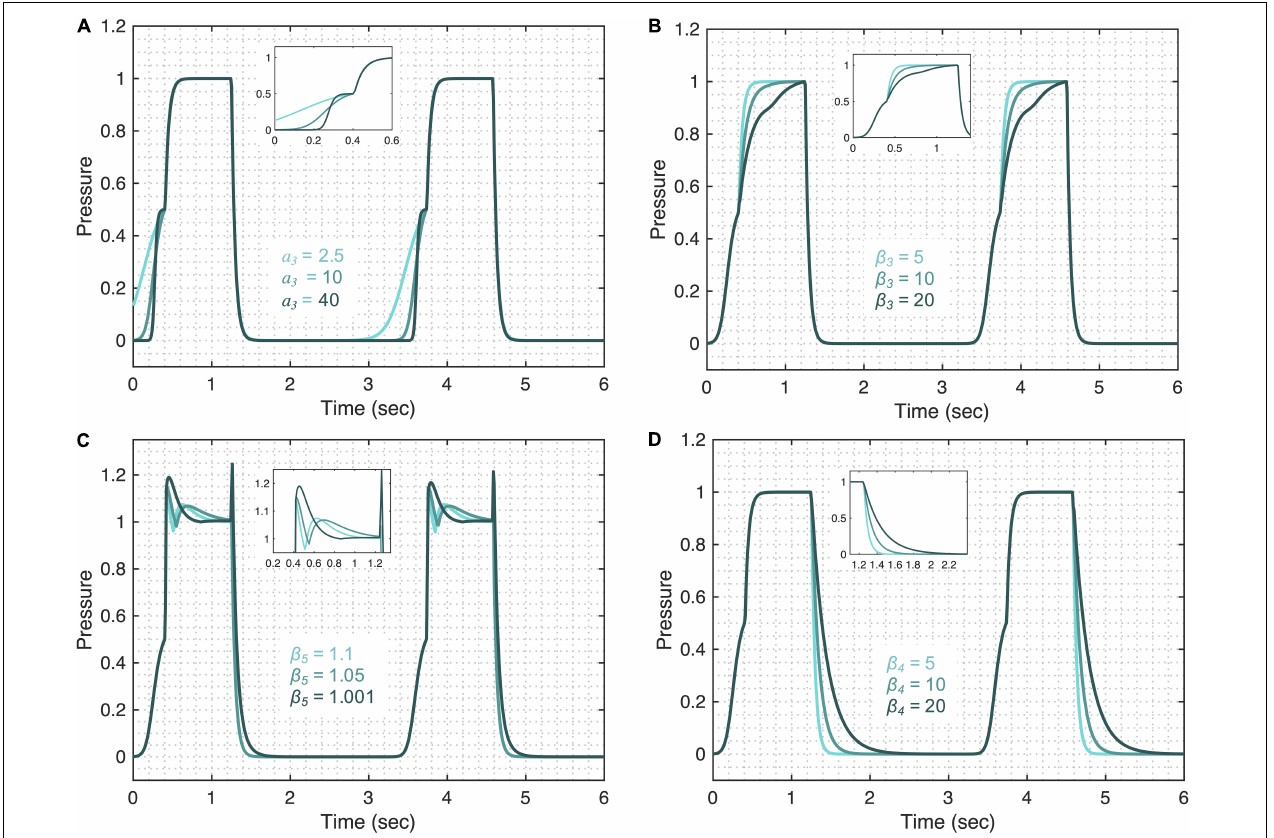
FIGURE 4 | Demonstrating the pressure model flexibility by altering relevant features in the pressure waveform. The initial gradient of the pressure signal during inspiration at low volume (feature A1) is controlled by (A) the a 3 parameter. (B) The gradient of the rising signal after the inflection point (feature A2), is controlled by the β 3 parameter. (C) The shapes of the peaks at the beginning (feature B1) and at the end (feature B2) of the plateau are regulated by the β 5 parameter when A p 4 = 0.5. (D) The gradient of the falling signal (feature C) during expiration can be modified by the β 4 parameter. Equations 6–18 were used to simulate the response of the pressure model while considering θ = 0.3, a 2 = 200, b 2 = 0.7, φ 2 = 0, a 3 = 10, b 3 = 0.9, φ 3 = –0.6, β 3 = β 4 = 5, β 5 = 1.001, β 6 = 1.1111, A p 1 = 1, A p 2 = 0.5, A p 3 = 0.5, and A p 4 = 0. The respective variations in the terms that make the pressure model are shown in the Supplementary Figure 3 for each case. Note that the model variability shown here is independent of the ventilator